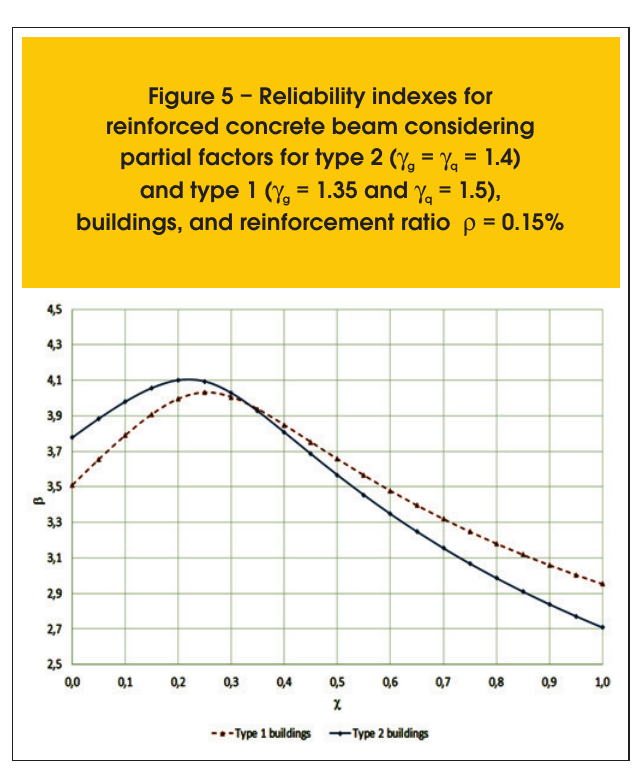
Figure 5 – Reliability indexes for reinforced concrete beam considering